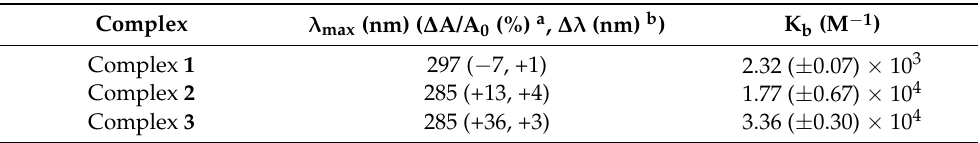
Table 8. UV-vis spectral features of the interaction of complexes 1 – 3 with CT DNA. UV-band ( λ max , in nm), percentage of the observed hyper-/hypo-chromism ( ∆ A/A 0 , in %), blue/red shift of the λ max ( ∆ λ , in nm), and DNA-binding constants (K b